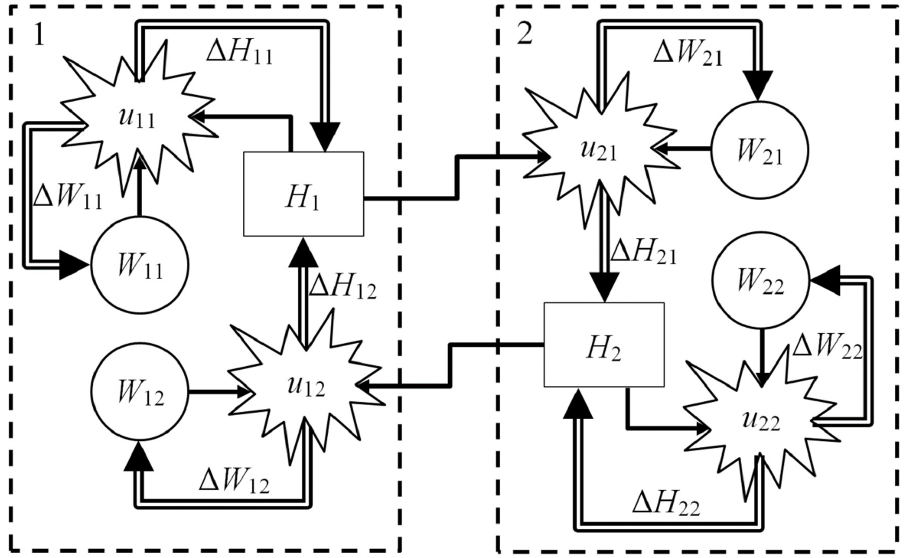
Figure 1. Scheme of control of the conflict situation with two participants and two external and two internal conflicts. The dashed frames indicate the persons (participants in the conflict situation). The stars show the conflicts (discrepancies); the double arrows show efforts made to change the parameters of the conflict. ∆ W ij and ∆ H ij are the control efforts applied by the person i and aimed at changing its own parameters W ij and H i